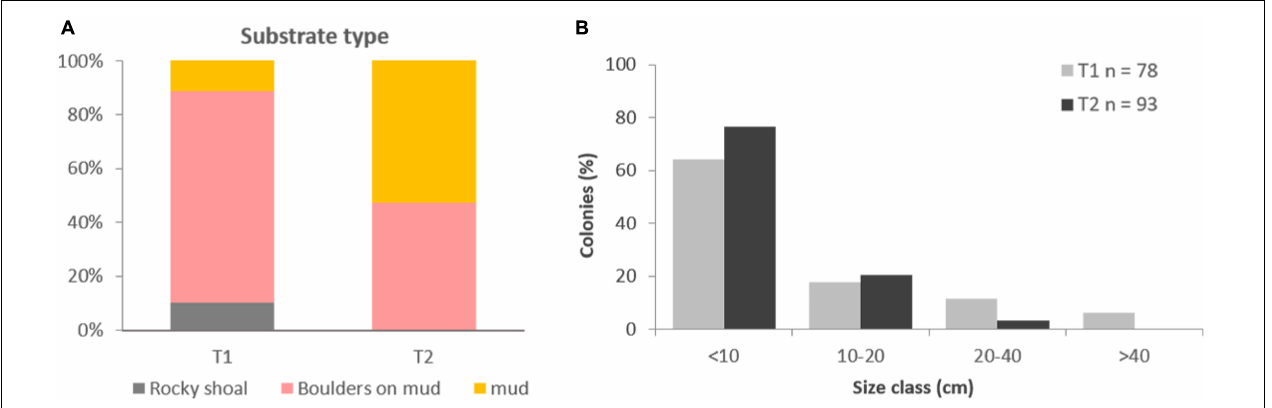
FIGURE 2 | (A) Percentage composition of substratum type. (B) Size distribution of colony height of D. ramea colonies in the study area.